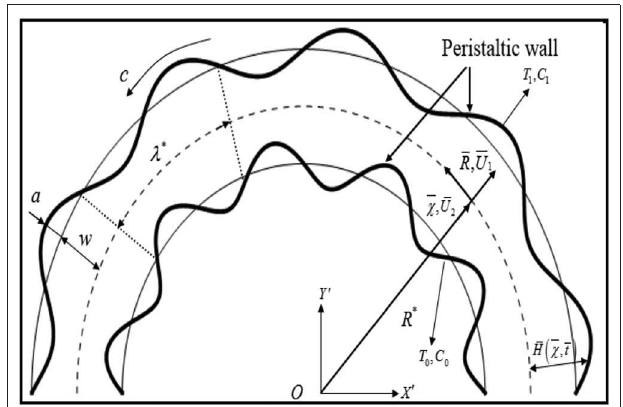
FIGURE 1 | Physical problem of the peristaltic flow